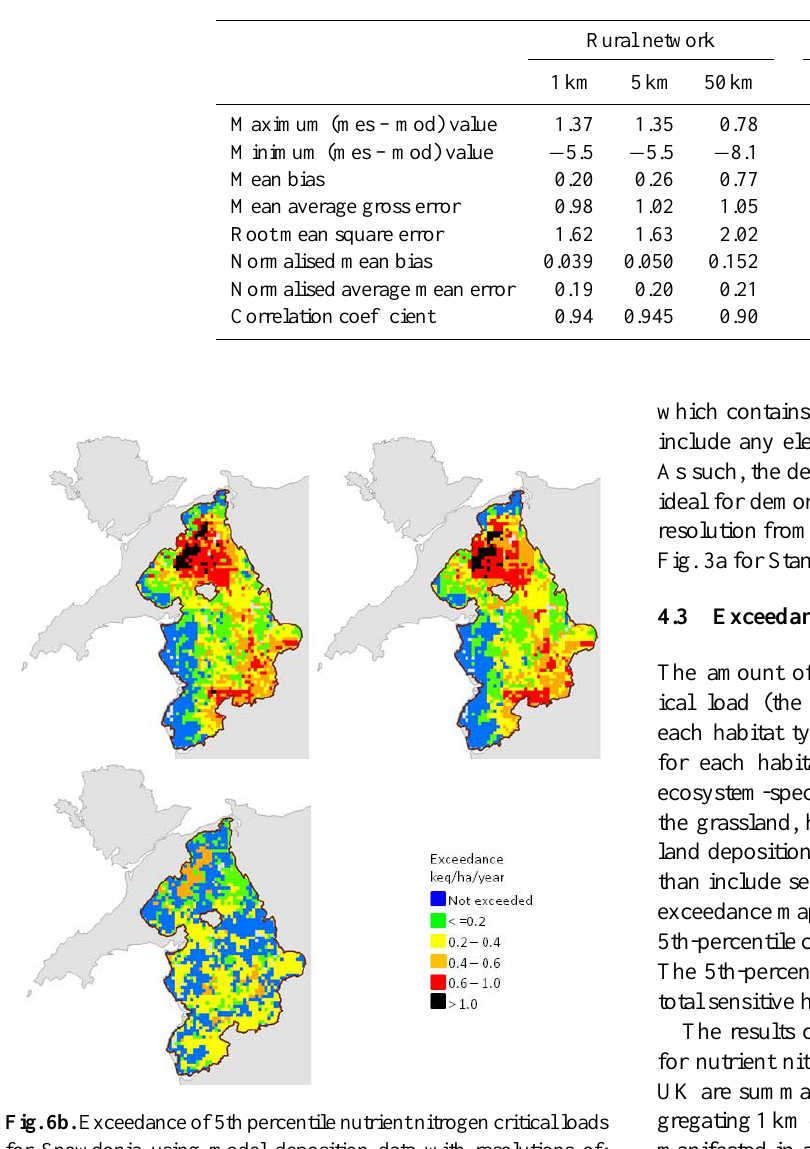
Table 2. Statistics for the model correlation with measurements of NO 2 concentrations from the rural monitoring and Automated Urban and Rural monitoring Networks (rural sites only) with data gridded at 1km, 5km and 50km resolution (mes: measured value; mod: modelled value). Units are in µgm − 3 except for the correlation coefficient which is dimensionless.